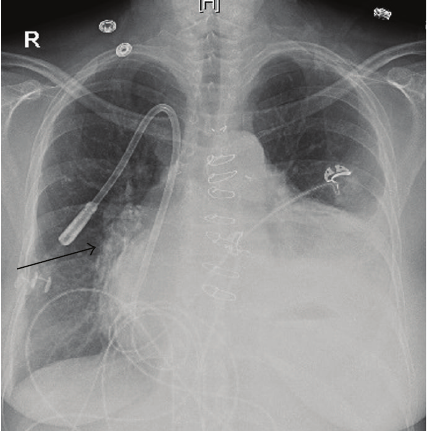
Figure 1: CXR showing airspace opacities with right hilar atelectasis and cardiomegaly.